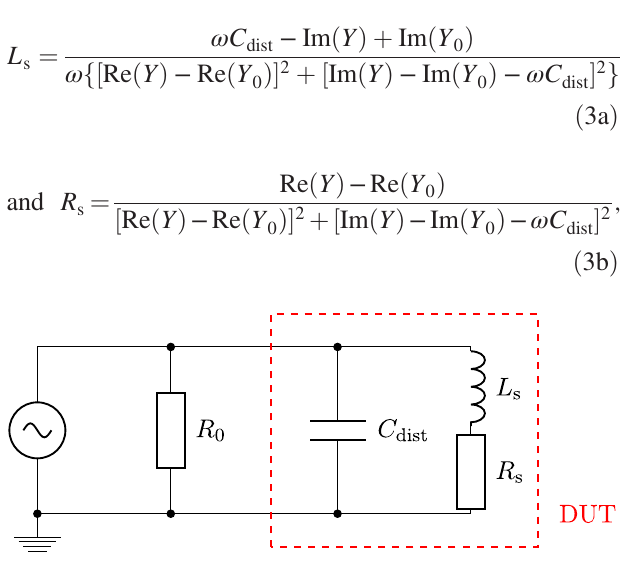
FIG. 2. Equivalent circuit diagram to represent the measure- ment setup. The resistor R 0 is installed in parallel to the device under test (DUT). The DUT itself is modeled as a distributed capacitance C in parallel with a series inductance L dist resistance R s